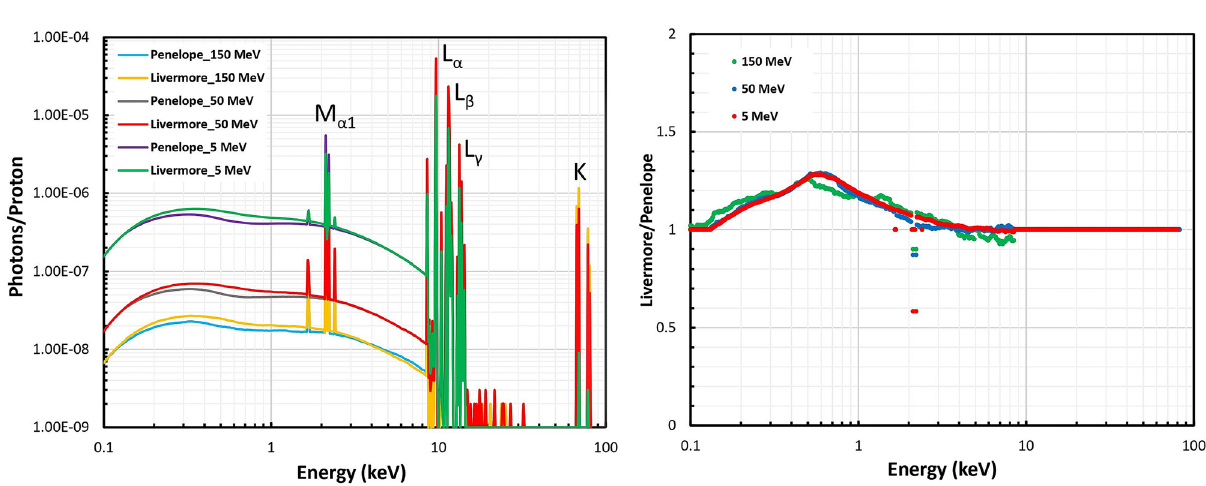
Figure 4. Comparison of the secondary photon spectra around the GNP between the Livermore and Penelope models obtained for 5, 50, and 150-MeV proton